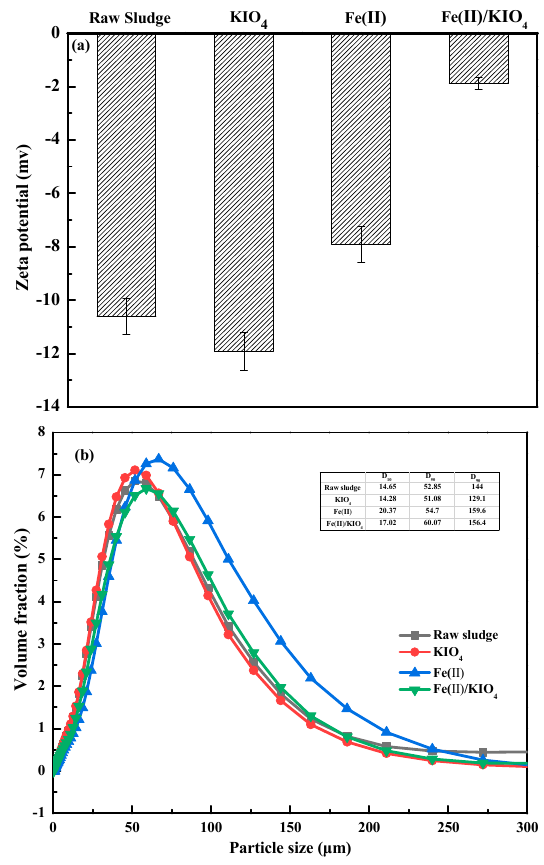
Figure 4. Variations of ( a ) Zeta potential and ( b ) particle size distribution of sludge flocs after treatment by different processes. Conditions: Initial pH = 6.8; KIO 4 dose = 1.4 mmol/g VSS, Fe( Ⅱ ) dose = 1.68 mmol/g VSS.